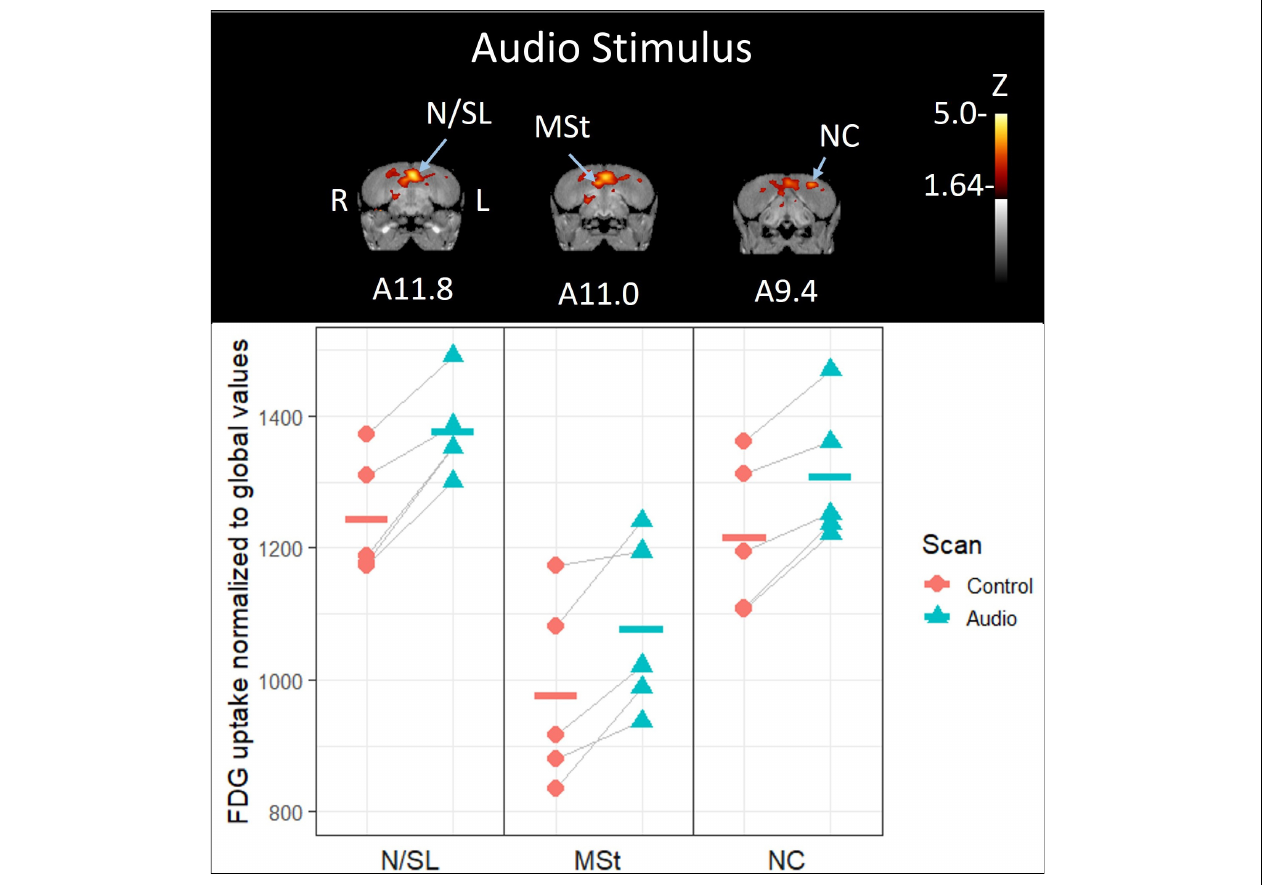
FIGURE 2 | Top: Coronal view of voxel-wise subtractions (converted to Z-scores) showing differential brain activity at the indicated region for all crows exposed to the vocalizations of feeding crows during their stimulus scan ( n = 5). Brain activity is superimposed atop a composite ( n = 4) structural MRI of the American crow brain. Slice coordinates (A11.8, A11.0, and A9.4) refer to Izawa and Watanabe (2007) jungle crow atlas. Bottom: individual normalized (global) uptake values obtained from VOI’s centered on peak activation coordinates. Horizontal lines indicate group means. Note that only the nidopallium/lateral septum border